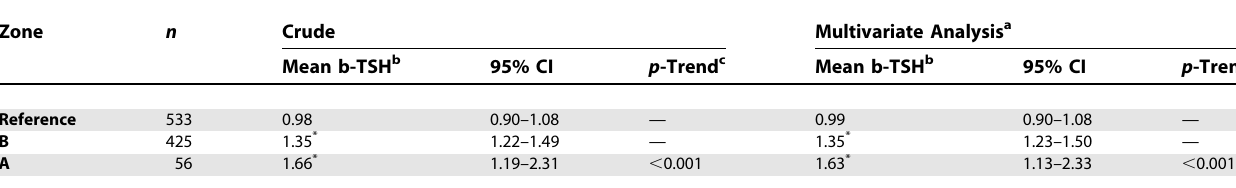
Table 2. Neonatal b-TSH Levels in Children Born between 1994 and 2005 to Women from Zone A (the Zone Most Contaminated after the Seveso Accident), Zone B, and the Surrounding Noncontaminated Area